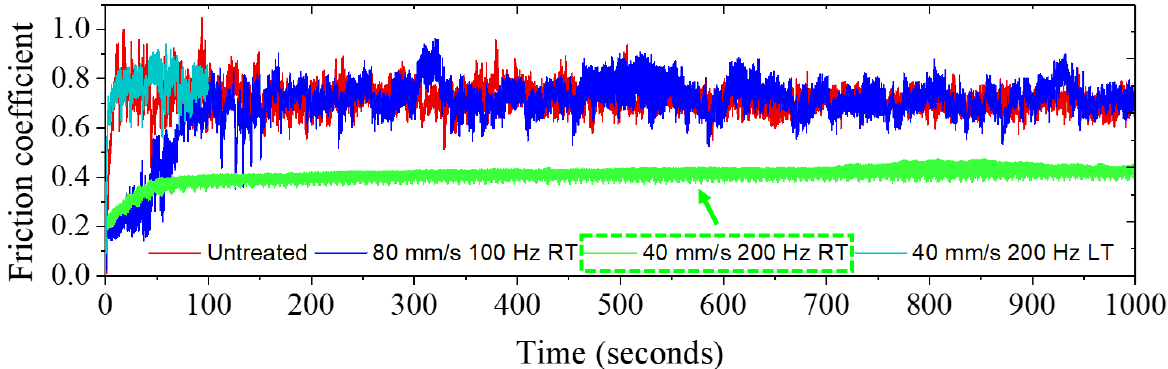
Figure 6. The friction coefficient with a wear time of NiTi alloy with different laser nitriding parameters.